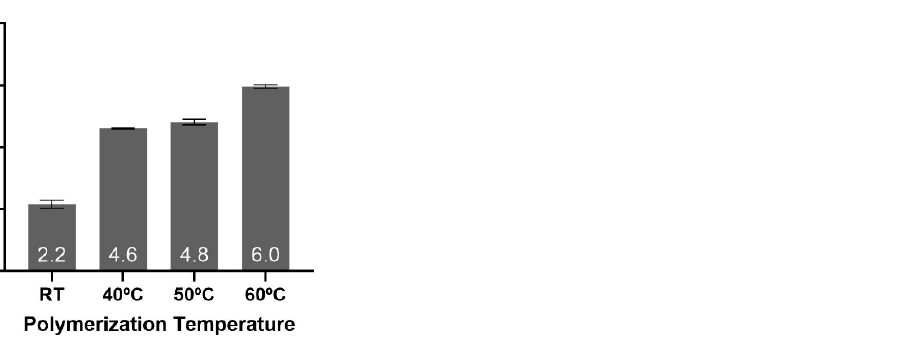
Figure 7. Polymerization shrinkage as a function of initial polymerization temperature. Data are presented as mean with SD.